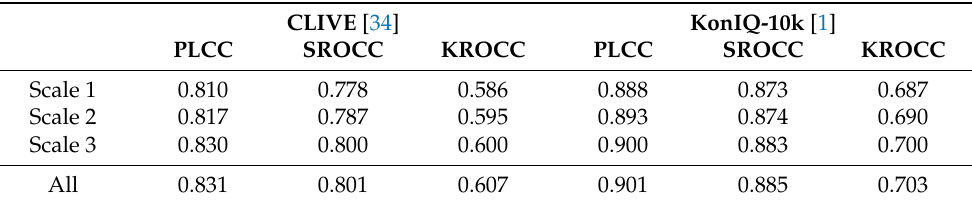
Table 6. Performance comparison of different scales on CLIVE [34]. Median PLCC, SROCC, and KROCC values were measured over 100 random train–test splits. CLIVE [34] KonIQ-10k [1] PLCC